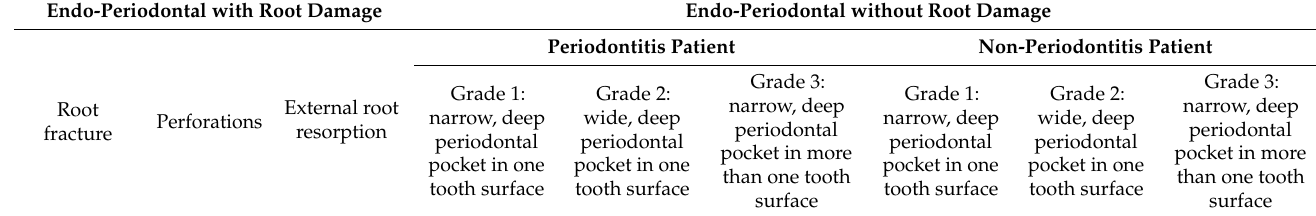
Table 1. Endo-periodontal new classification